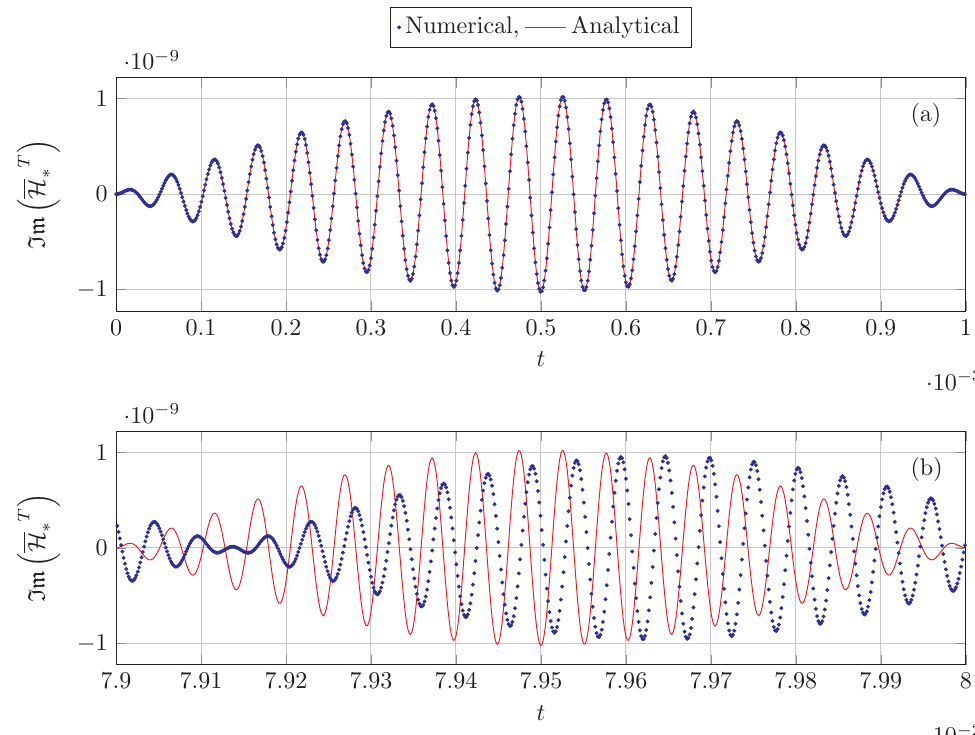
Figure 4. Comparison between the analytical expression and the numerical results for the magnetic part of the Weyl tensor in the even sector. The perturbation length scale was chosen as L = 10 − 5 L H , and the background was specified using Equation (163). The initial magnitude of the magnetic field on the background was chosen so that v A ( t 0 ) = 0.95. As for the initial perturbations, these were chosen according to Equations (174) and (175). In all calculations, k η ( t 0 ) = 10 − 12 . The plots show: ( a ) numerical and analytical solutions starting at the initial time t = 0; ( b ) numerical and analytical solutions when the time ∆ t = 0.079 has